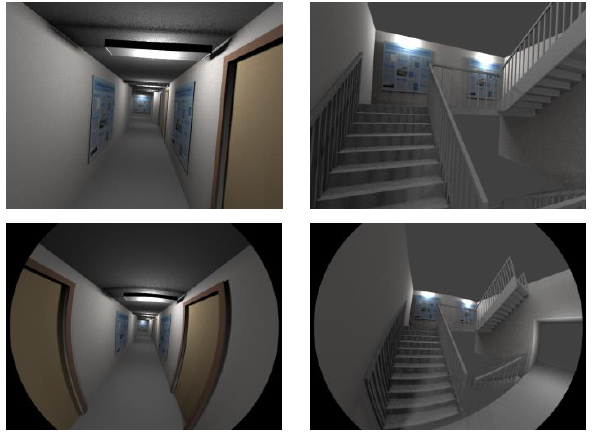
Figure 5. Example images from the sequence recorded using a simulated perspective camera ( top ) and a simulated fisheye camera ( bottom ).